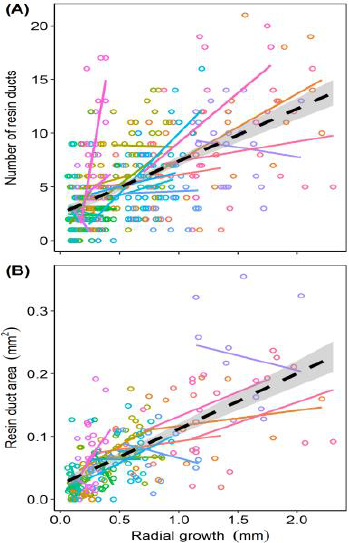
Figure 2. The relationship of annual resin duct counts ( A ) and cross-sectional resin duct area (mm 2 per year) ( B ) to annual radial growth (mm per year). Both panels show untransformed data. Colored symbols and solid lines correspond to individual trees, the larger dashed line shows the population line of fit with shading indicating the 95% confidence interval.